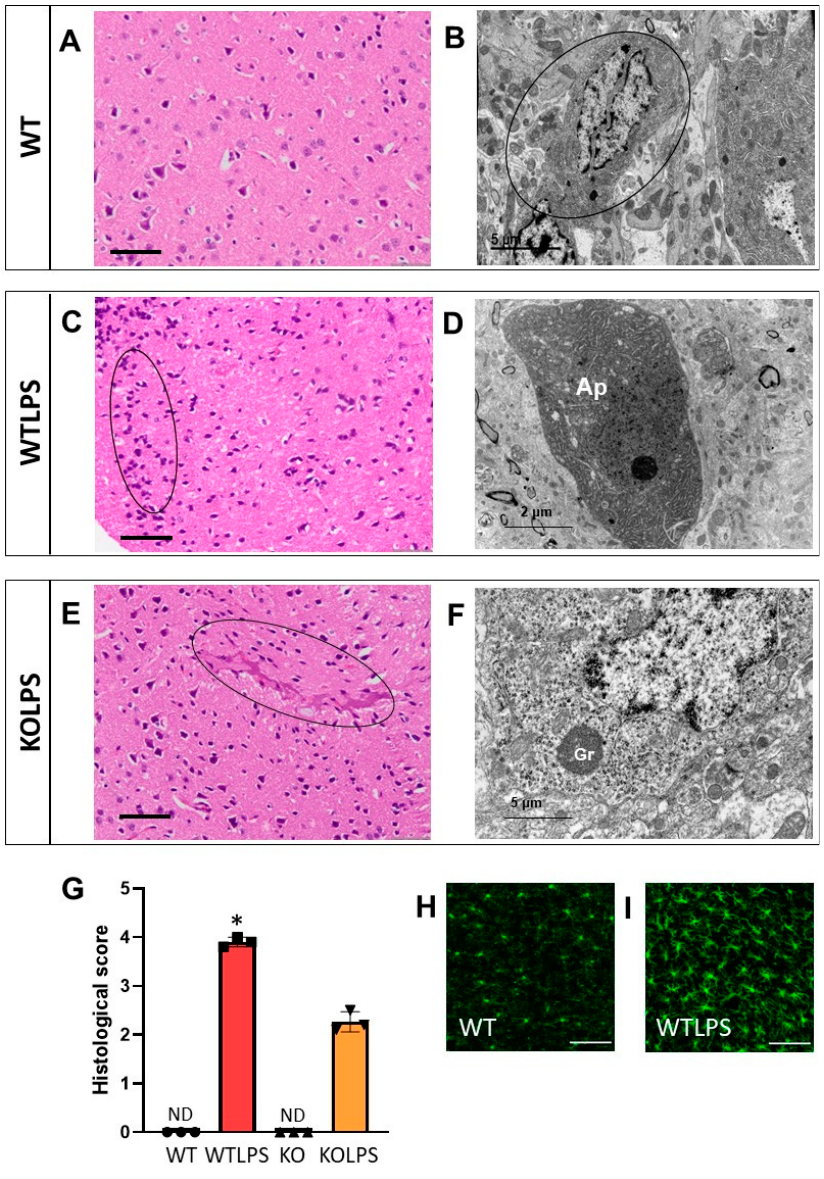
Figure 13. Histopathology of the brains of mice from the different treatments assayed. ( A ) Detail of cerebral cortex with abundant neurons. ( B ) Detail of apparently normal neuron and oligodendro- cyte (circle). ( C ) Detail of cerebral cortex, showing mobilization of glia cells (circle). ( D ) Detail of a damaged neuron densified and vacuolized. ( E ) Detail of cerebral cortex with a tenuous hyperemia (circle). ( F ) Detail of neuron with lipofucsin precursor granules (Gr). ( G ) Histological score showing brain damage. The pathology scores were as follows: 0, without significant injuries (0%); 1, mini- mum (<10%); 2, mild (11–25%); 3, moderate (26–50%); 4, marked (5–75%); 5, severe (>75%). Histo- pathological evaluation is performed in a blind manner by two highly experienced pathologists.